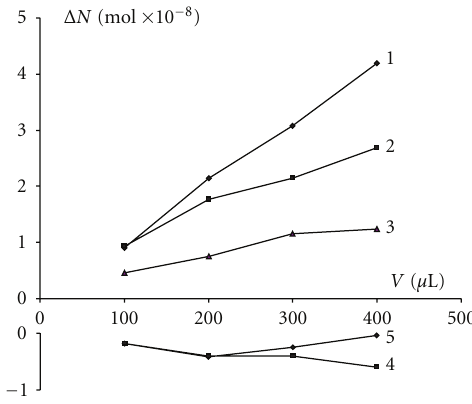
Figure 3: The dependence of false oxygen consumption caused by various factors on the volume of additives. (1) oxygen-free additive, (2) cooled additive, (3) absence of salts in the additive, (4) high concentration of salt in the addition, and 5: high viscosity of